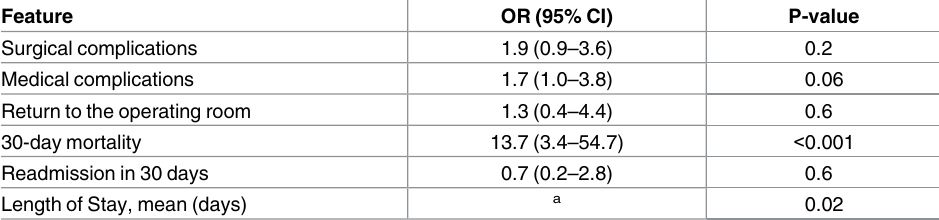
Table 6. Outcomes of patients with diabetes with and without complications.